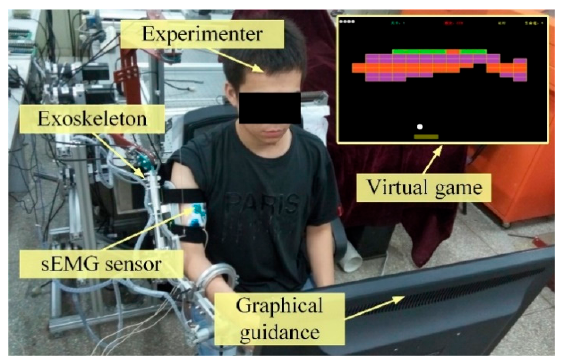
Figure 6. The upper-limb exoskeleton prototype worn by a volunteer looking at the graphical